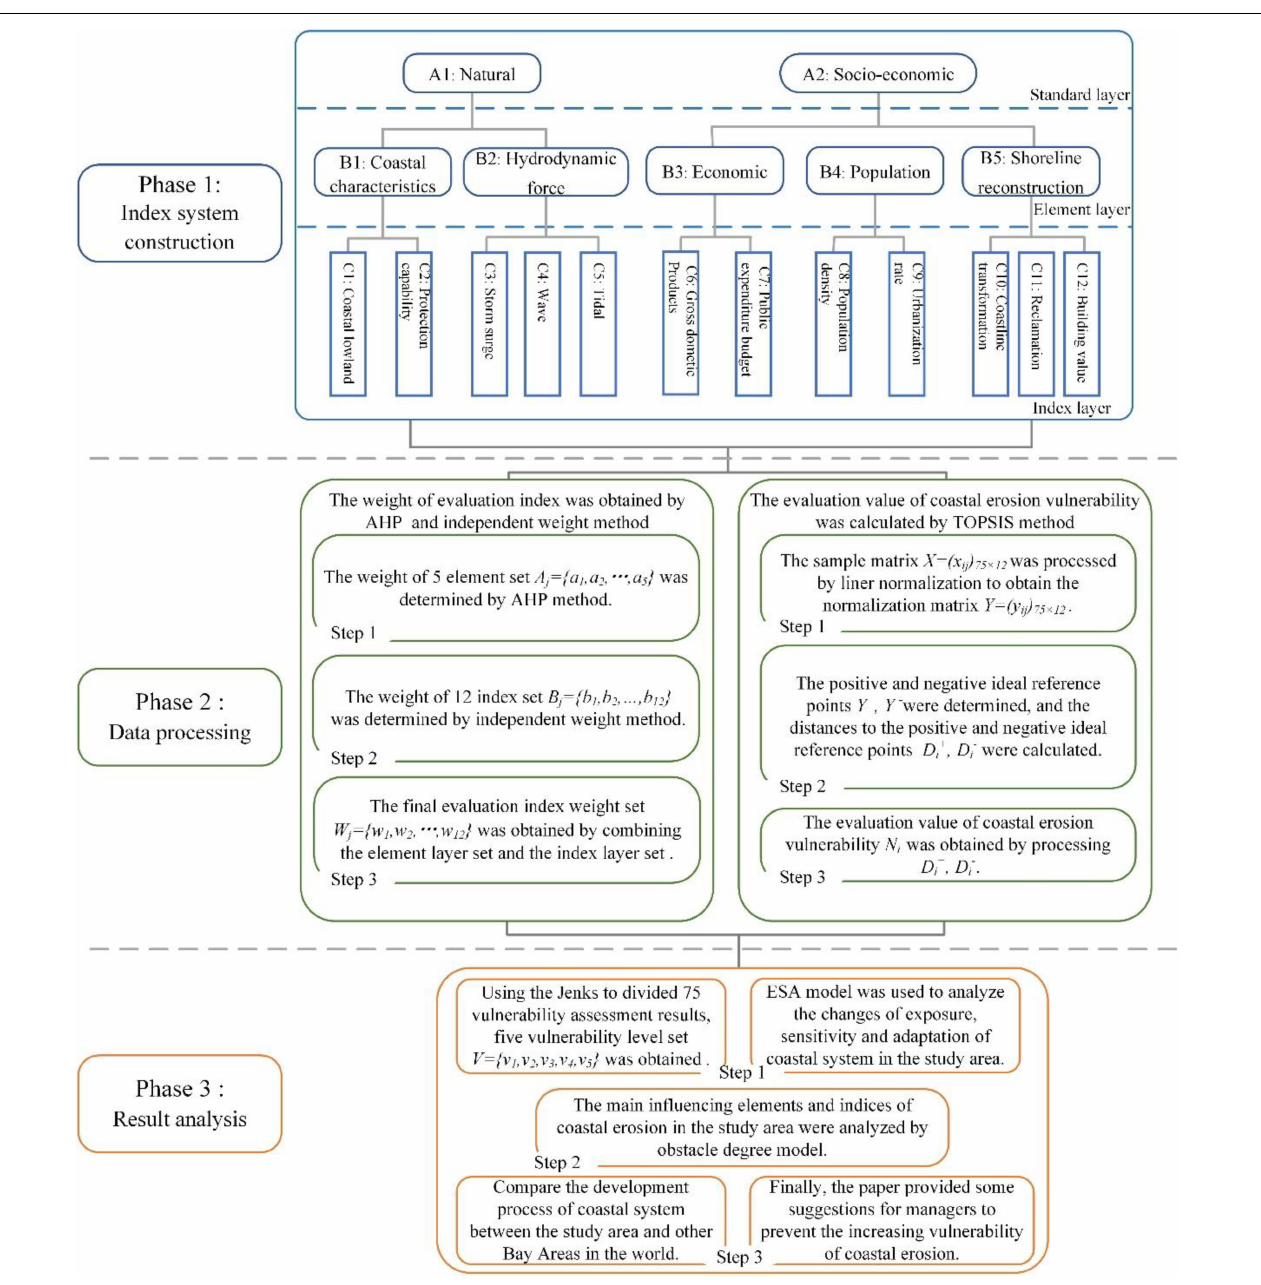
FIGURE 2 | Flow chart of the technical methods used in this study. This study consists of three phases: Index system construction, data processing and analysis of the results. The corresponding tables of numerical symbols and acronyms in this paper are described in Supplementary Table 1 .